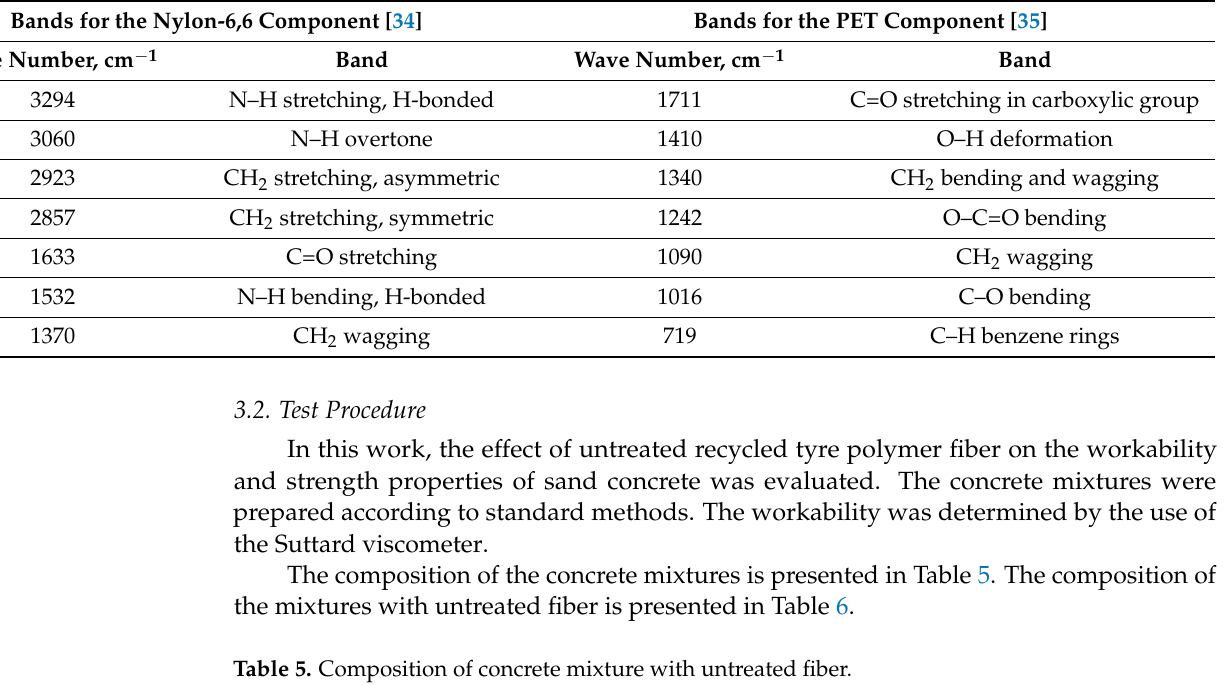
Table 4. The absorbance bands from FTIR spectra for the fiber sample.